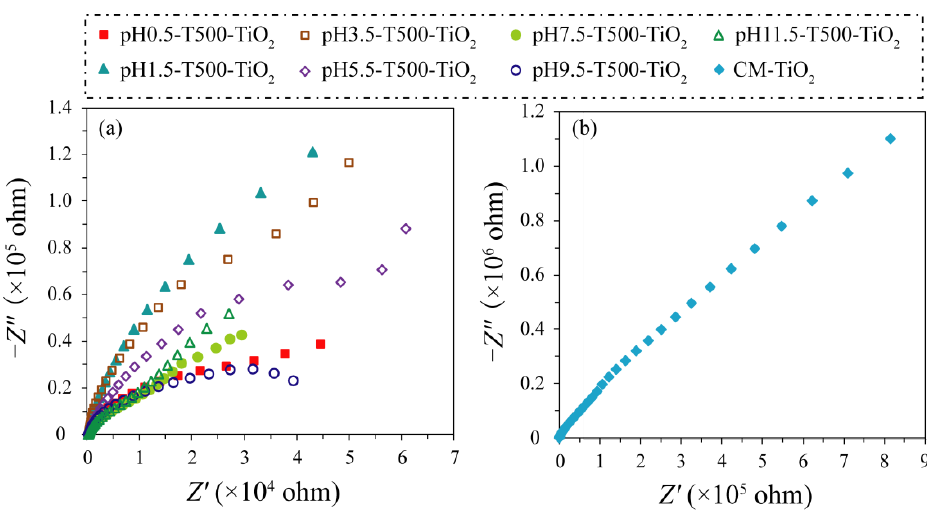
Figure 7. EIS Nyquist plots the (a) pH x − T500 − TiO 2 and (b) CM − TiO 2